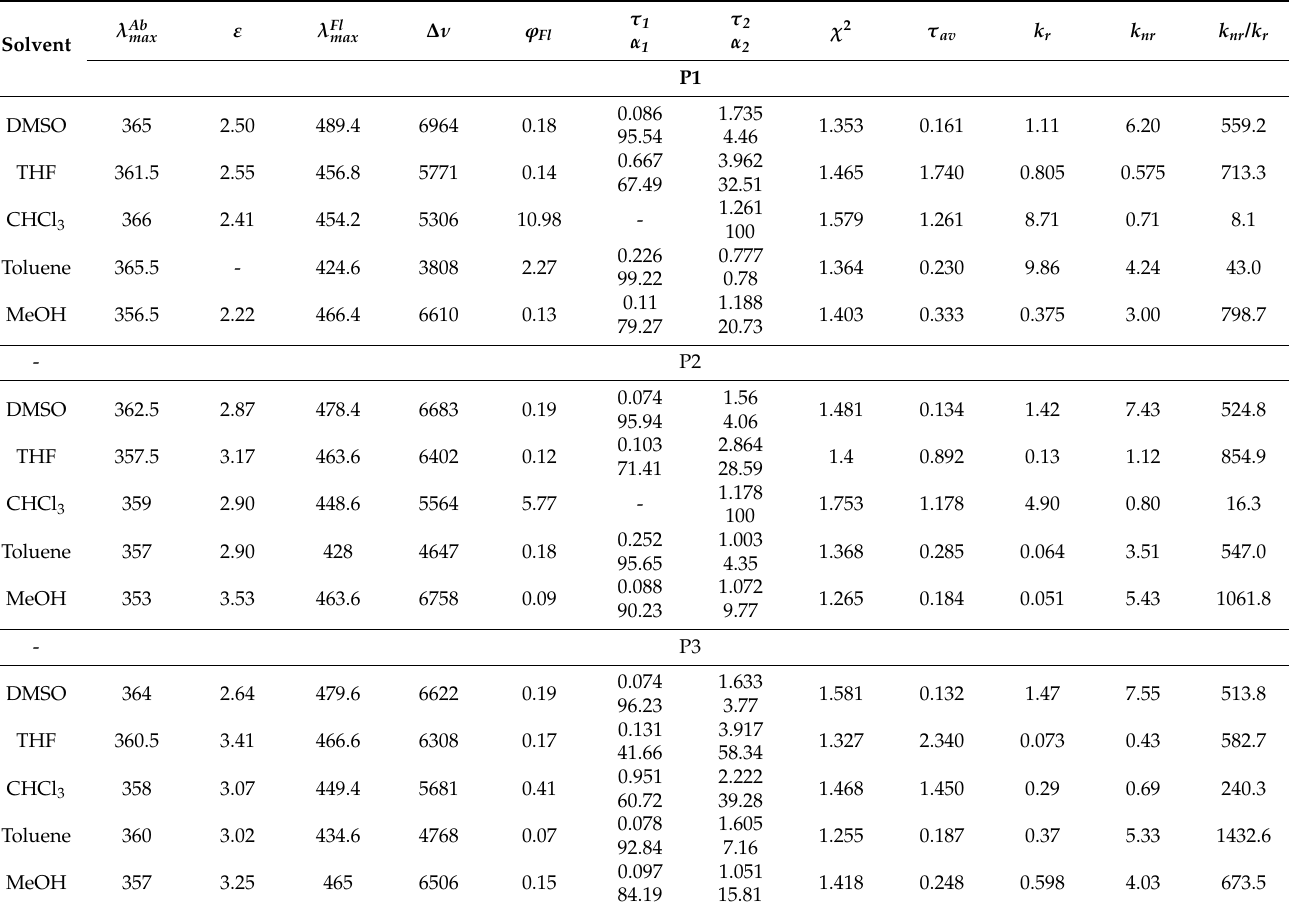
Table 1. Main photophysical parameters a for tested